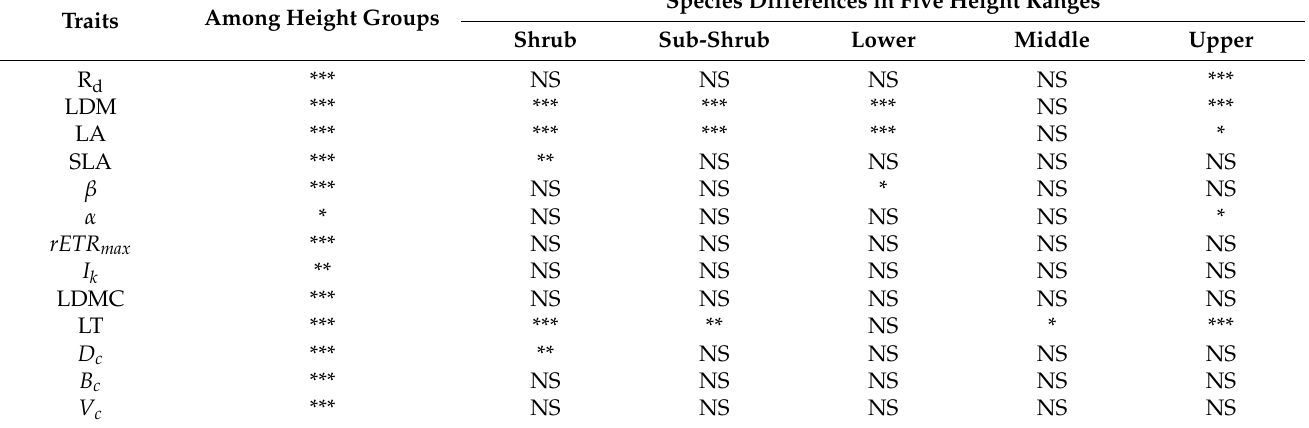
Table A3. The results of one-way analysis of variance (ANOVA) of functional trait differences among height groups, and results of ANOVA of species differences in functional traits in five different height